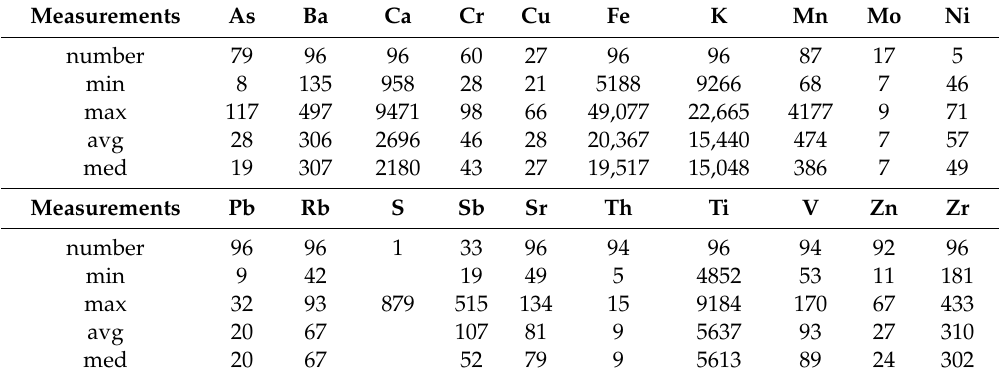
Table 1. pXRF measurements with over 20% observations above LOD, B horizon soils (pXRF, in mg /